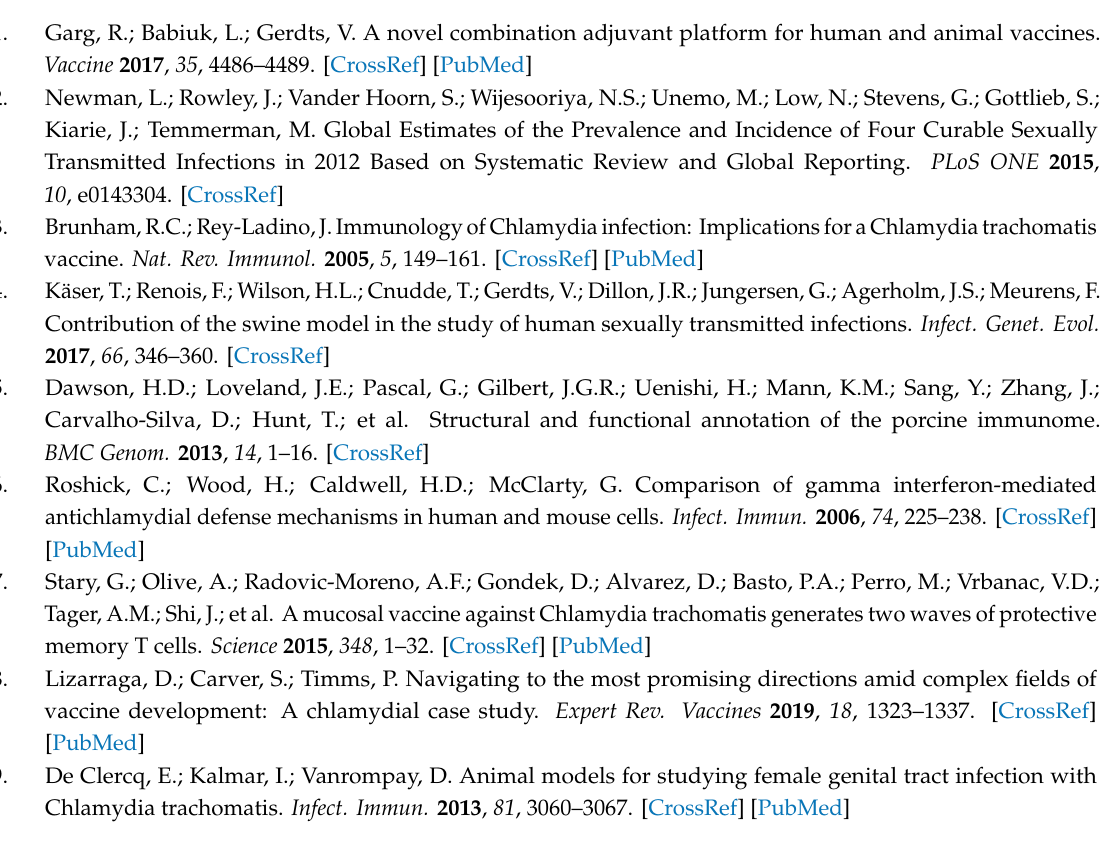
Figure S1: Gating hierarchy for PBMC proliferation analysis via flow cytometry. Figure S2: Gating hierarchy for PBMC intracellular cytokine analysis via flow cytometry. Figure S3: Reanalysis of blood CD4 T cells isolated by magnetic activated cell sorting via flow cytometry. Figure S4: Antibiotic treatment eliminates vaginal C. suis load and decreases rectal C. suis load. Figure S5: Serum anti- C. suis antibody levels in commercial pigs from high-health farms. Table S1: Blood CD4 + T cell total mRNAs profiled using